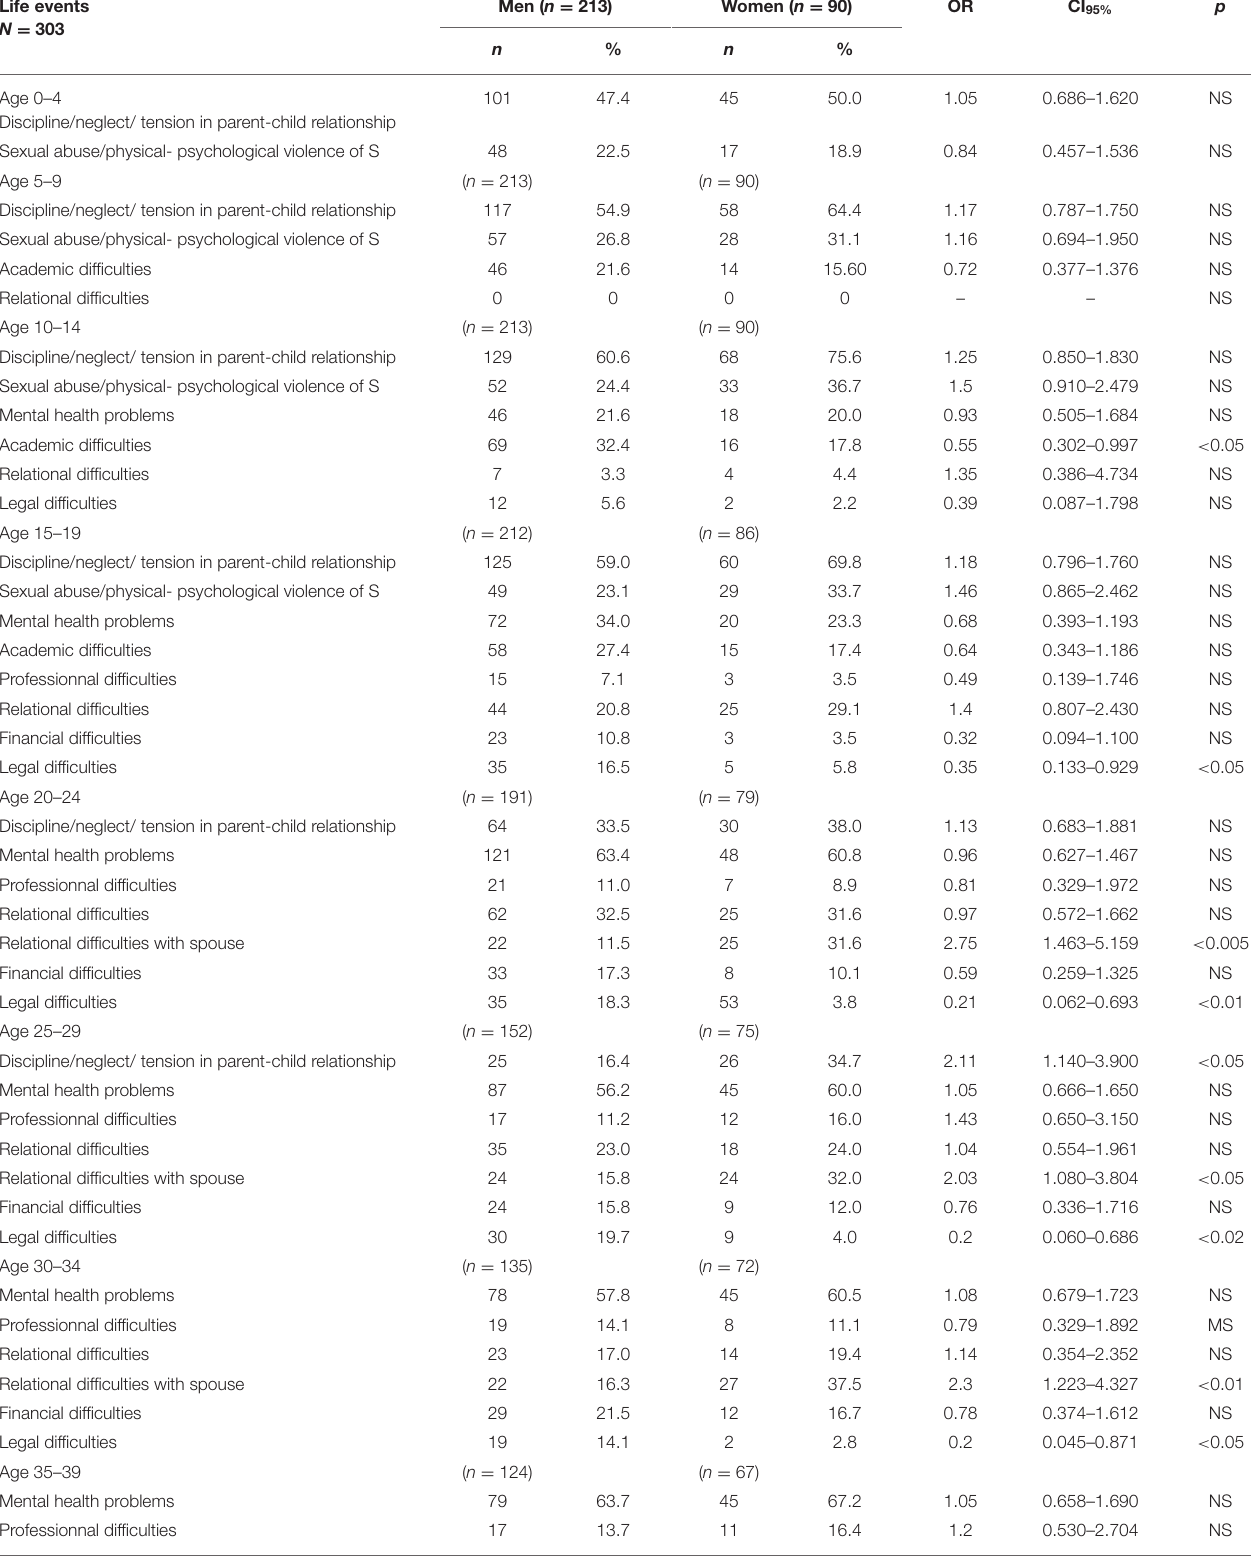
TABLE 3 | Life events: comparison between man and women. Life events N =